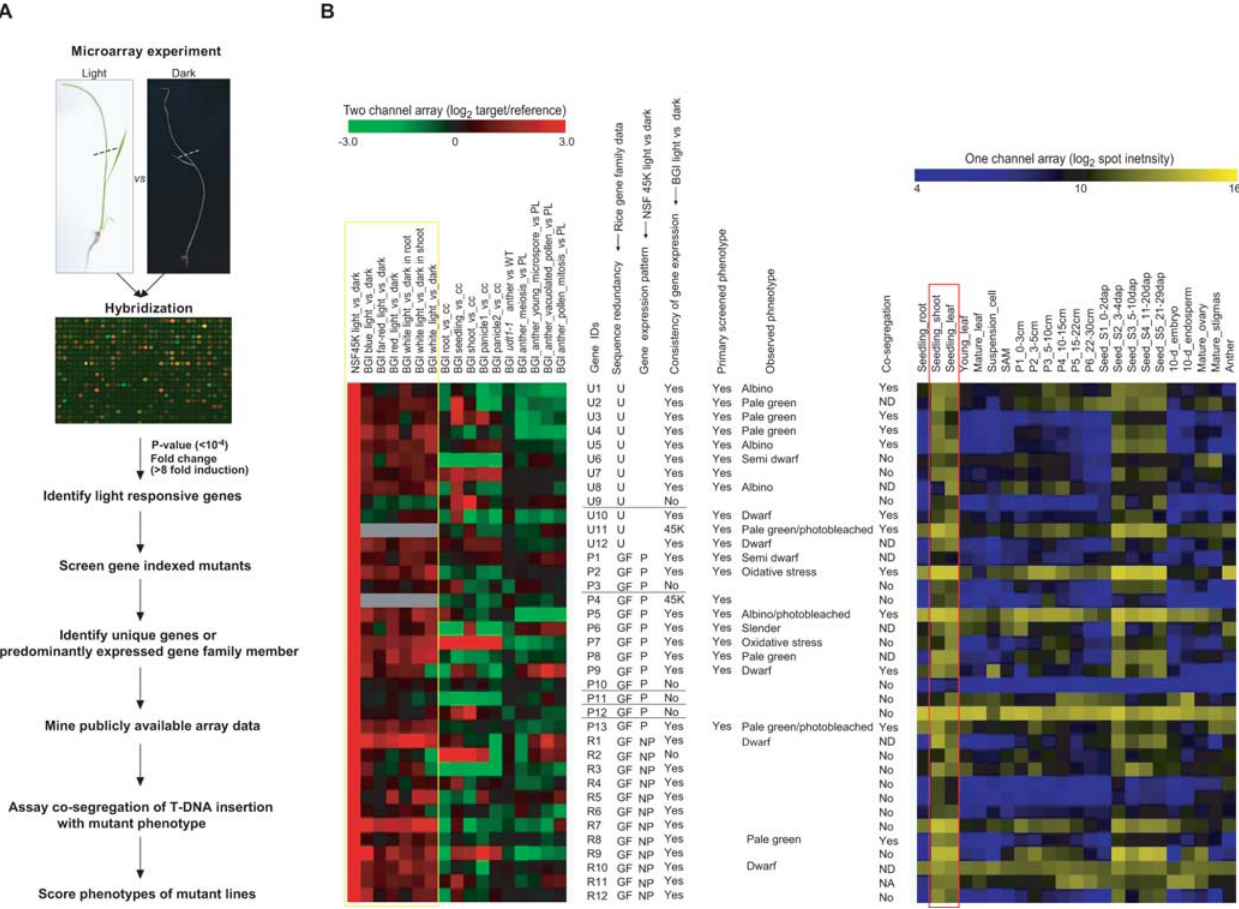
Figure 2. Strategy Used to Refine the List of 37 Candidate Genes Prior to Functional Validation and Summary of Phenotype Analysis. (A) The flow chart of functional analysis using microarray and gene-indexed mutants. (B) Gene expression patterns of selected 37 candidate genes and summary of functional analyses using gene-indexed mutants of these genes. Figure 2A is adapted from a previous review article [4]. Dotted lines in Figure 2A indicate the cut region of rice seedlings used for this array experiment. The NSF45K and BGI/Yale light vs. dark array datasets were used to refine the list of 37 candidate genes prior to functional validation. Unique genes (U), genes without gene family members, are distinguished from genes (GF) with gene family members. The gene among the gene family members predominantly expressed in the light was marked as P, distinguished from non predominant genes (NP). The consistency of a gene’s expression pattern among the NSF45K and BGI/Yale light vs. dark array data was noted with a Yes or No or 45K; 45K indicating the unavailability of any other reference array data for comparison. The genes for which functional analyses was performed are marked Yes. Co-segregation of the observed phenotype and a T-DNA insertion is indicated by Yes, No or ND; ND indicates that co-segregation was not determined due to somaclonal variation or problems with primers. Yellow box indicates rice light vs. dark microarray data derived using NSF45K and BGI/Yale array. Red box indicates gene expression data in leaf, seedling shoot, and young leaf derived using the Affymetrix